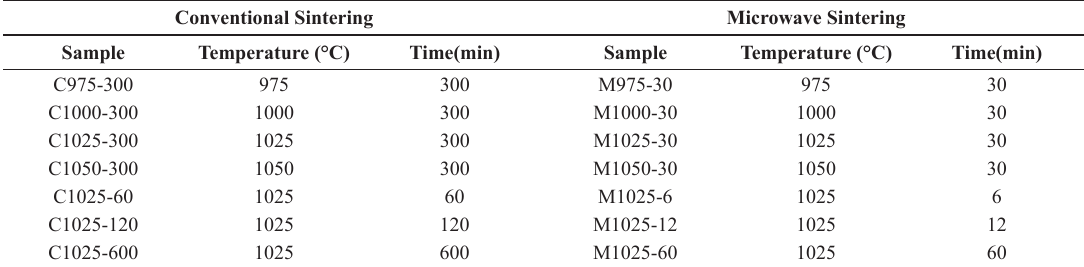
Table 1. Conditions of dwell time and temperature for conventional and microwave